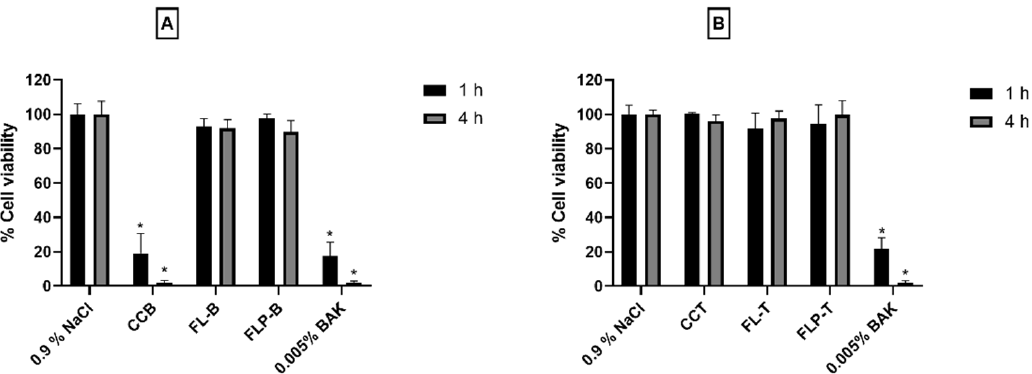
Figure 3. In vitro toxicity evaluation in human conjunctival cells of liposomal formulations containing brimonidine (FL-B and FLP-B) ( A ) or travoprost (FL-T and FLP-T) ( B ) after 1 and 4 h exposure. FL-B: Brimonidine 0.2%, DOPC 7.5 mg/mL, DMPC 2.5 mg/mL, vitamin E 0.1 mg/mL Ubiquinol 0.025 mg/mL, Taurine 0.5%, Ribitol 0.5%; FLP-B: Brimonidine 0.2%, DOPC 7.5 mg/mL, DMPC 2.5 mg/mL, Vitamin E 0.1 mg/mL Ubiquinol 0.025 mg/mL, Taurine 0.5%, Ribitol 0.5%, HPMC 0.2%. FL-T: 40 µ g/mL, DOPC 7.5 mg/mL, DMPC 2.5 mg/mL, vitamin E 0.1 mg/mL Ubiquinol 0.025 mg/mL, Taurine 0.5%, Ribitol 0.5%; FLP-T: Travoprost 40 µ g/mL, DOPC 7.5 mg/mL, DMPC 2.5 mg/mL, vitamin E 0.1 mg/mL Ubiquinol 0.025 mg/mL, Taurine 0.5%, Ribitol 0.5%, HPMC 0.2%. * Statistically significant difference with respect to the negative control ( p < 0.05).